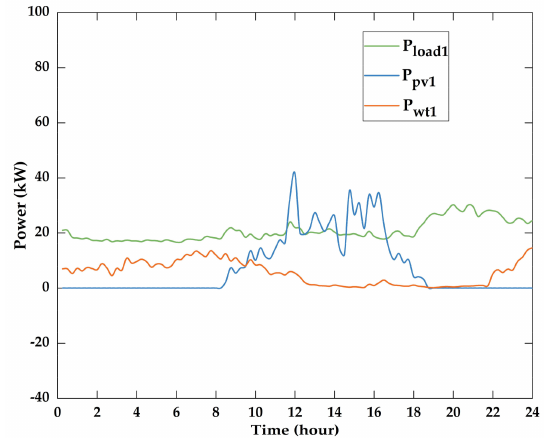
Figure 11. Power in module A.